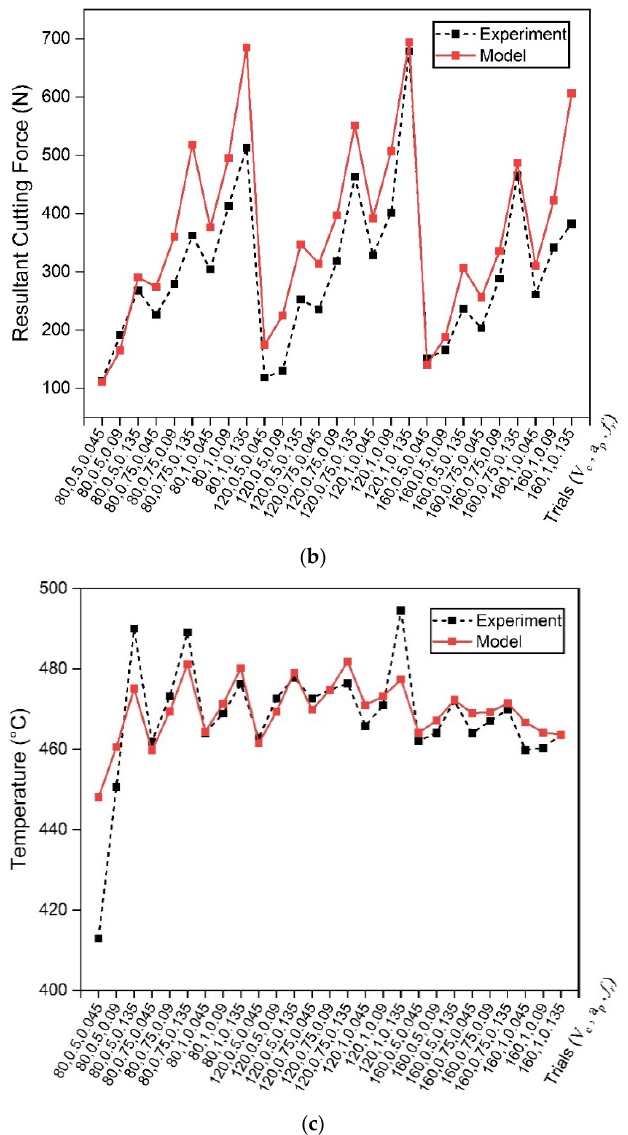
Figure 13. The comparison between experiment and model results, ( a ) surface roughness (Ra), ( b ) resultant cutting force (R), and ( c ) temperature (T).